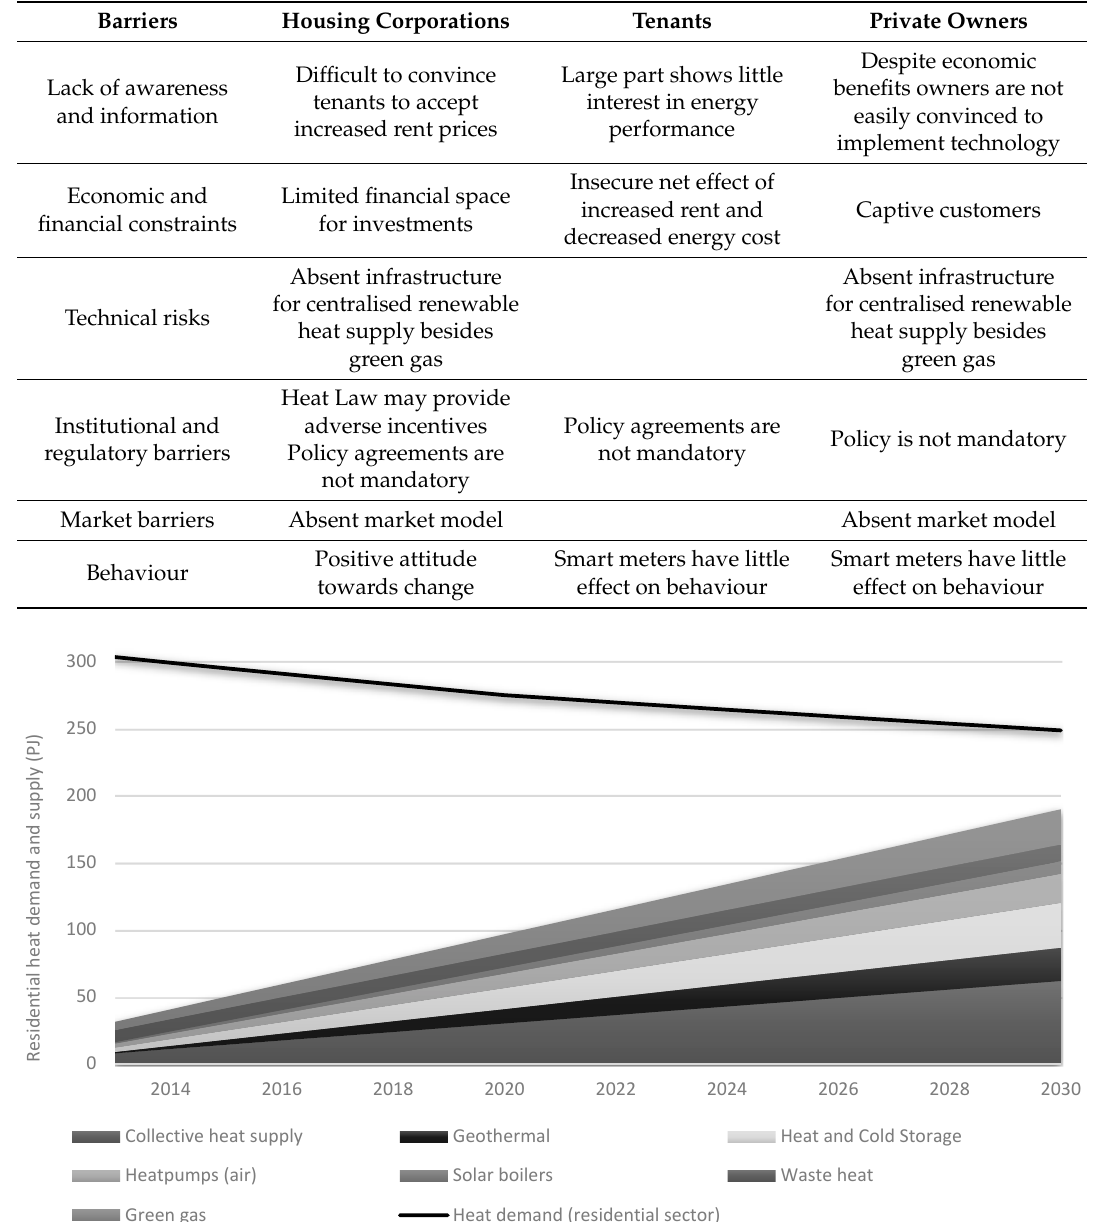
Figure 3. Residential heat demand for space heating, hot water and cooking. The demand for cooking is marginal (i.e., roughly 7.5 PJ, based on 32 m 3 · household − 1 [77]); the demand for hot water is about 63 PJ based on an average showering time of 8.12 min [77], a flow rate of 10 litre · min − 1 and a temperature difference of 30 Kelvin. The remainder is required for space heating. Data are in petajoule (10 15 joule).